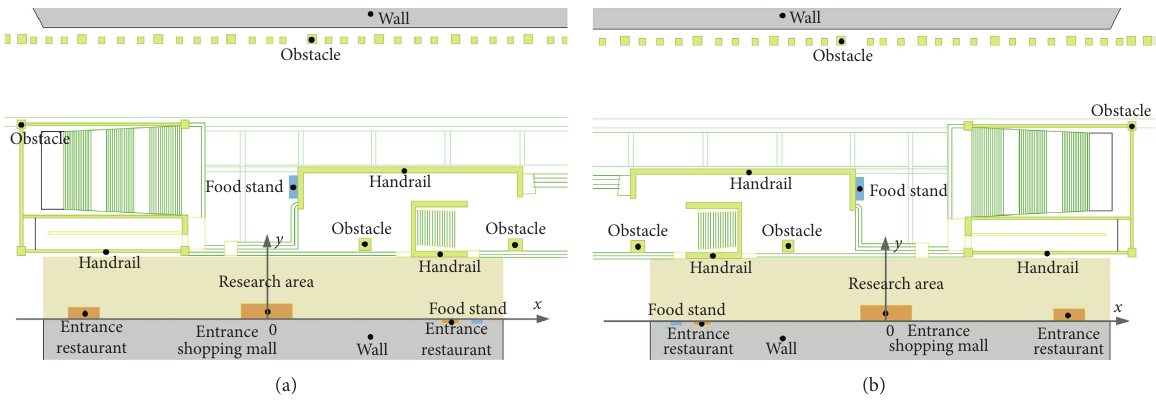
Figure 4: Schematic of the coordinate system. (a) Coordinate system for pedestrians coming from the left. (b) Coordinate system for pedestrians coming from the right.